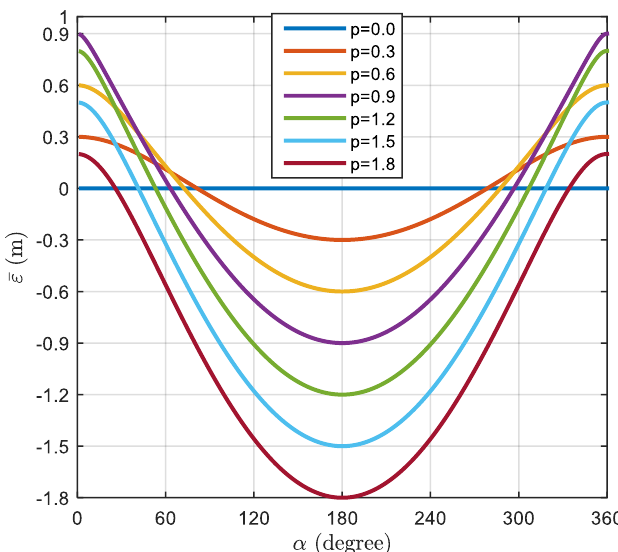
Figure 5. The relationship between the initial position offset and the misclosure error.